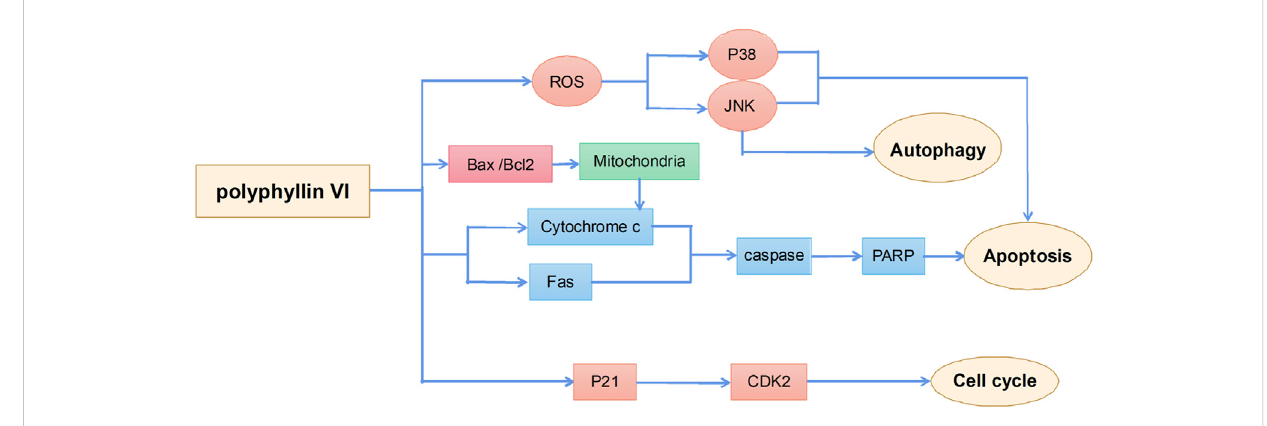
The primary mechanism for the anti-tumor effects of Polyphyllin